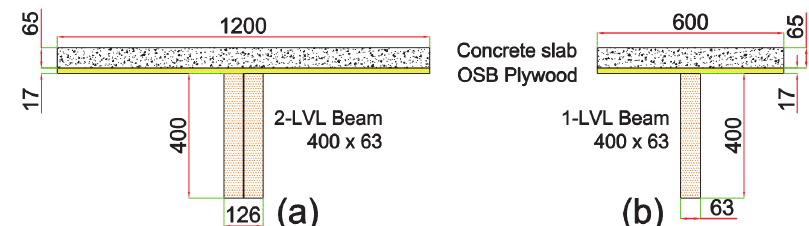
Figure 2: The cross-section of the tested TCC beams: (a) F1 and G1, (b) the reduced section of the rest (dimensions in mm) [14]. The connections type include notches cut in the timber and reinforced with a coach screw of 16 mm diameter (rectangular notches of 150 mm and 300 mm long) and triangular notch, and modified toothed metal plates pressed on the edge of the LVL joists, abbreviated R150, R300, T and P respectively, Fig. 3 presents these four connections.